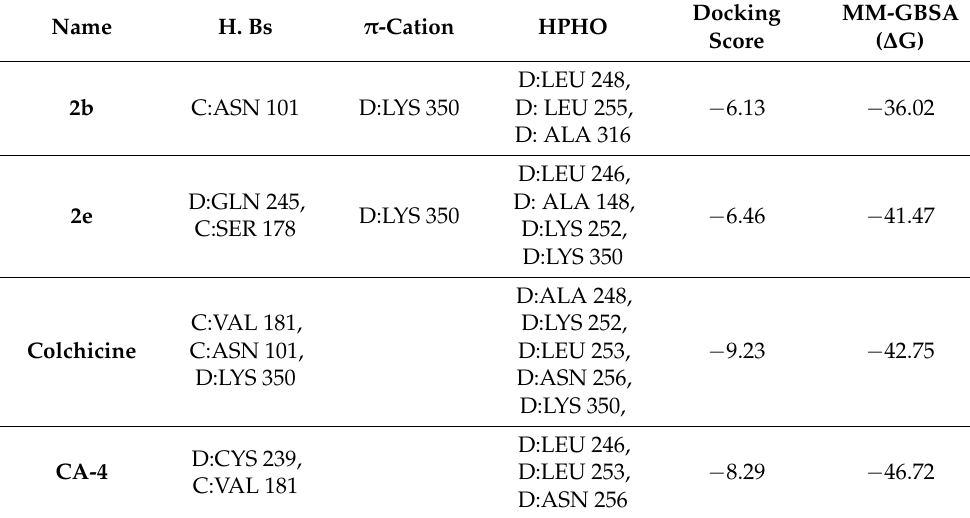
Table 2. The interaction pattern, docking scores, and MM-GBSA values of colchicine, CA-4, 2b , and 2e compounds within tubulin-binding pocket